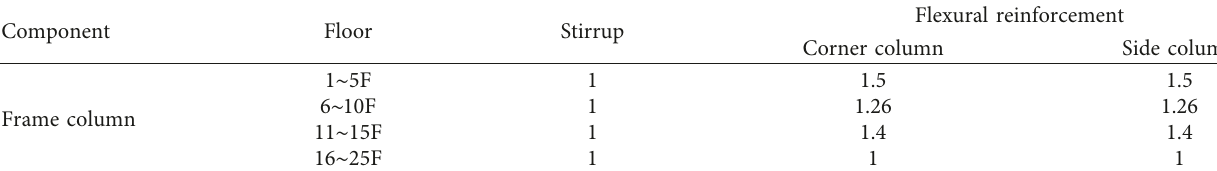
/ ρ in frame column. O N